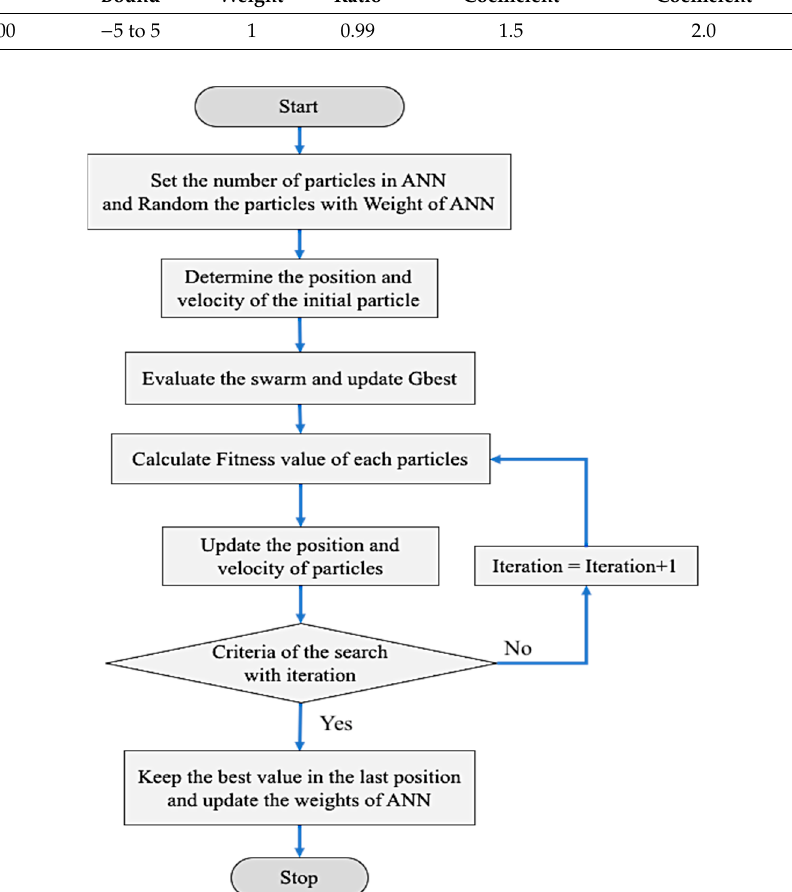
Figure 7. Diagram of the operation of the hybrid PSO-ANN forecast model.